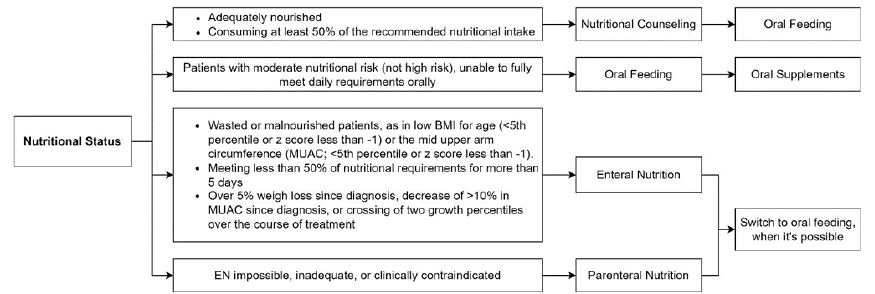
Figure 3. Possible nutritional interventions based on nutritional status.